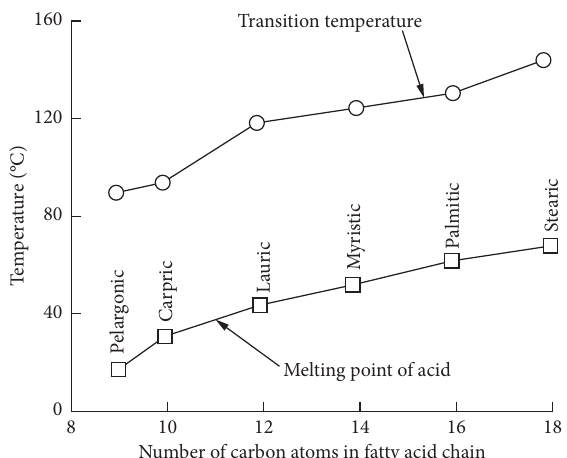
Figure 13: Transition temperature on the steel surface and melting of fatty acids as a function of chain length [14].